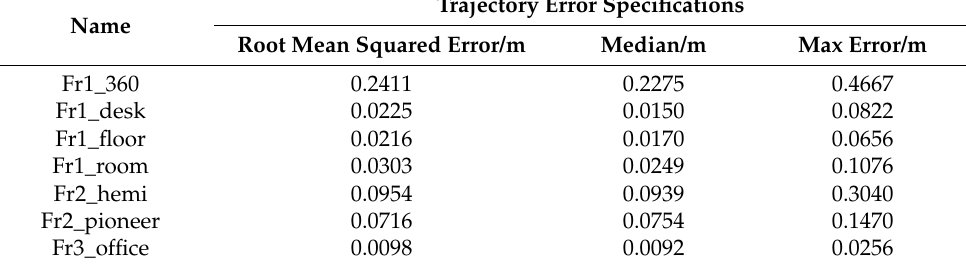
Table 1. SLAM trajectory evaluation.